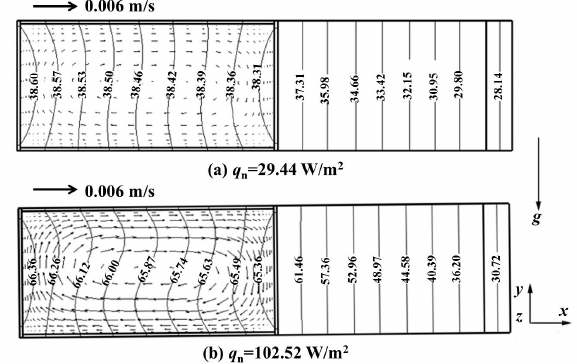
Fig. 7. The velocity and temperature fields when the test wall is placed vertically (z=0.0025 mm): (a) q n = 29.44 W/m 2 ; (b) q n = 102.52 W/m 2 .